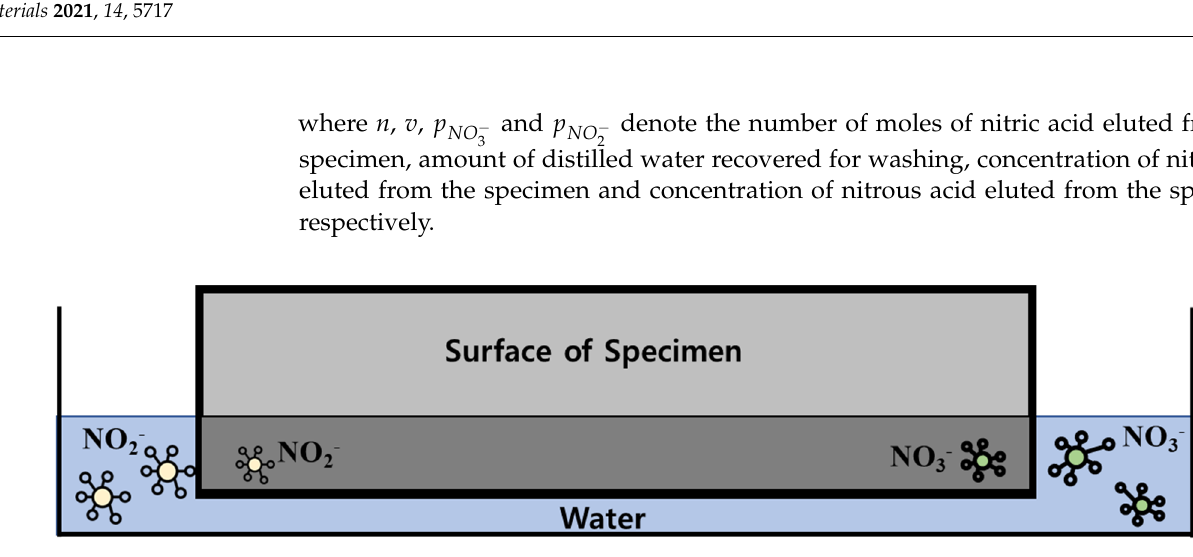
Figure 5. Overview of the washing water experiment of the specimen specified in ISO 22197-1.